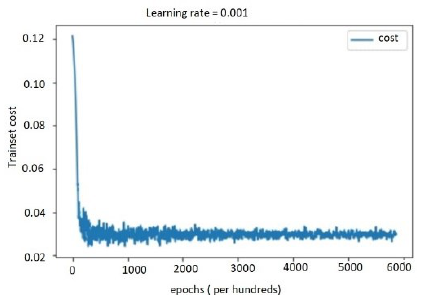
Figure 7. Training cost versus epochs for text